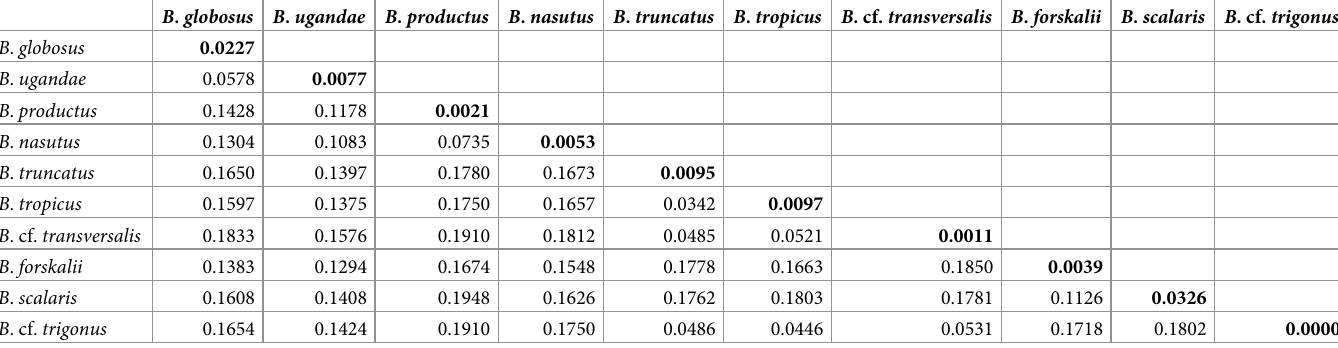
Table 2. Intra- and Interspecies p -distance values of partial cox1 of 68 bulinid sequences. B . globosus B . ugandae B . productus B . nasutus B . truncatus B . tropicus B . cf. transversalis B . forskalii B . scalaris B . cf.